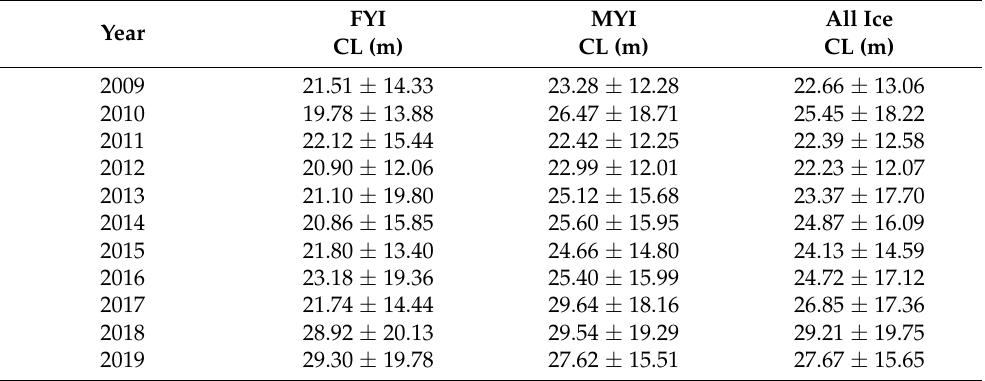
Upper CL limit set at 150 m.